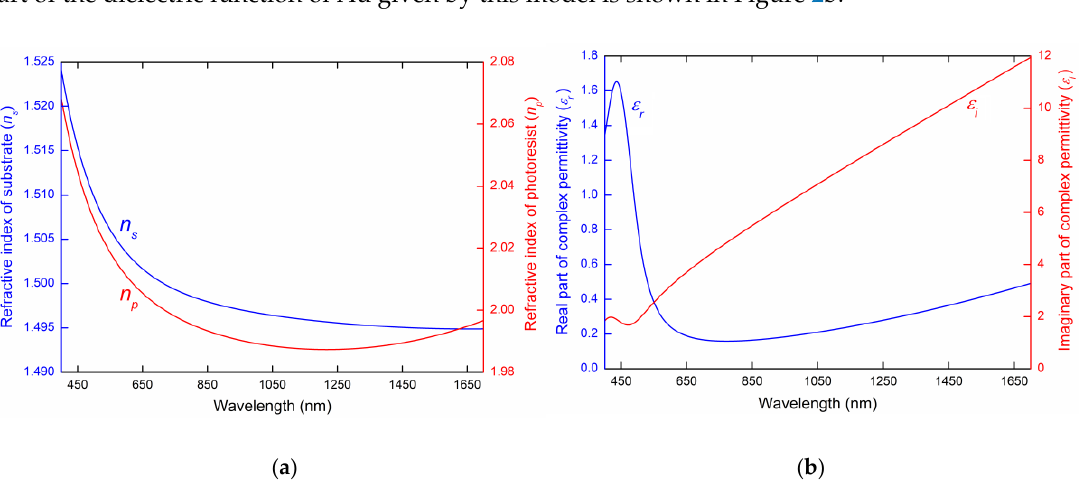
Figure 2. Dispersion of used materials. The refractive index of the substrate (blue line) and AZ1505 photoresist (red line) given by the Cauchy formula ( a ) and the real part (blue line) and imaginary part (red line) of the complex permittivity of the Au layer given by the Drude–Lorentz model ( b ). Table 1. Parameters of the dielectric function of